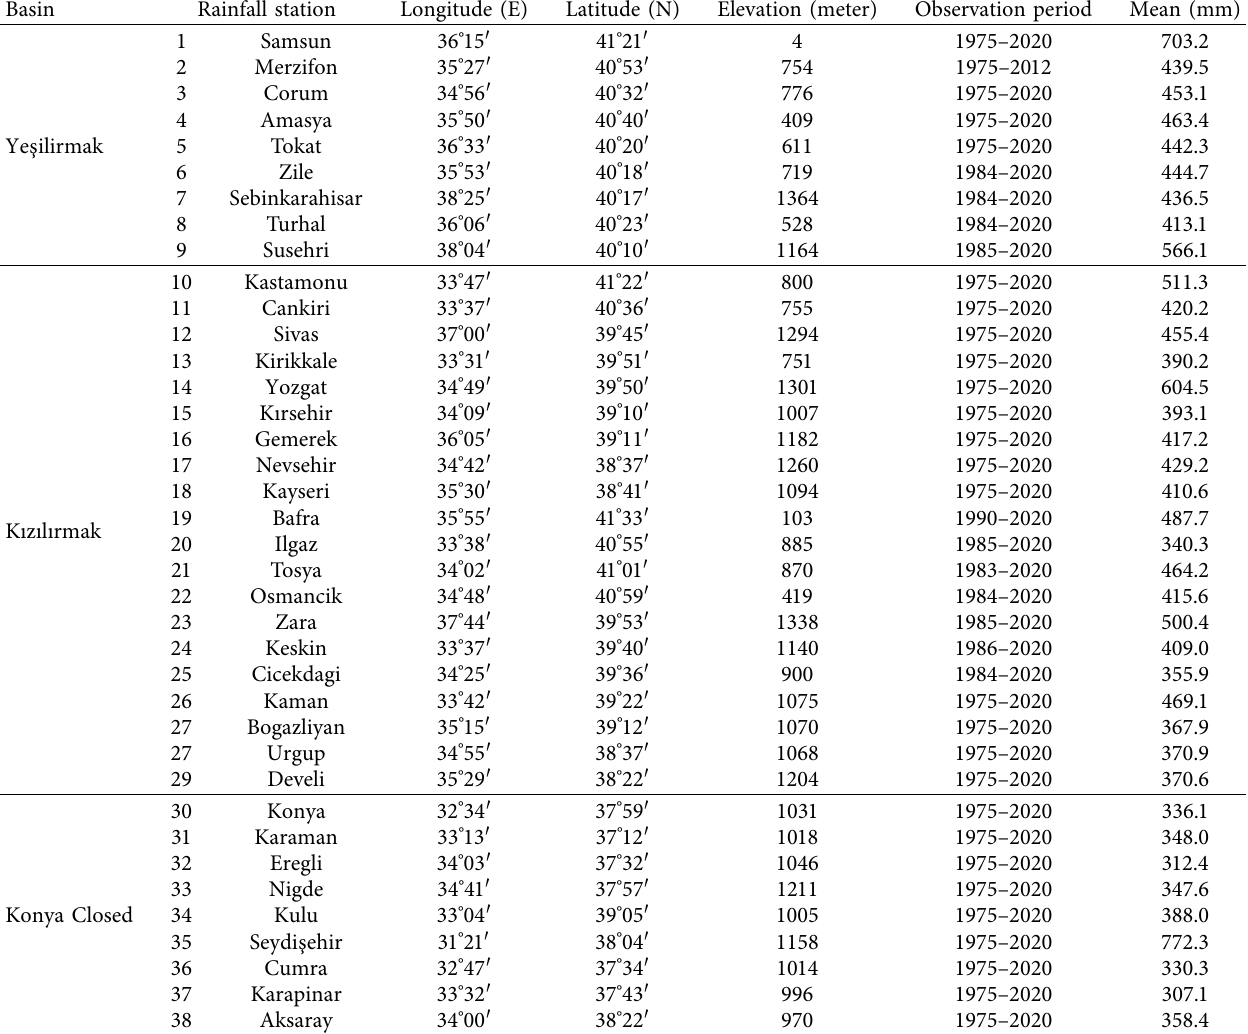
Table 1: Some features of the rainfall stations in the study